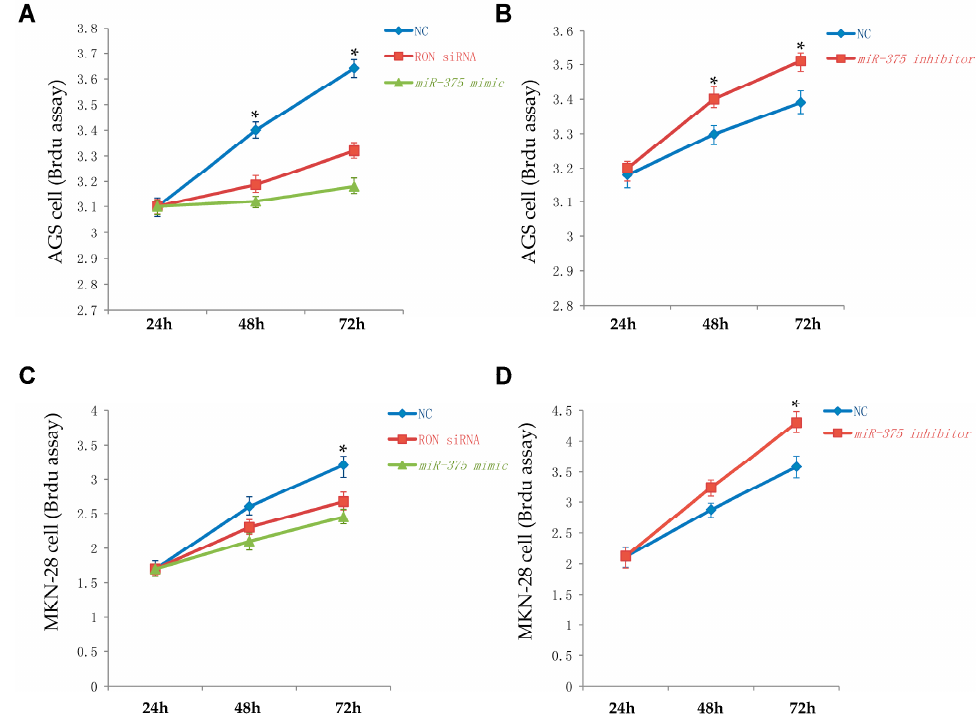
Figure 3. miR-375 and RON regulate cell proliferation in AGS and MKN-28 human gastric cancer cells. ( A ) Brdu assay in AGS cells transfected with a miR-375 mimic, a negative control, or RON siRNA; ( B ) Brdu assay in AGS cells transfected with a miR-375 inhibitor or a negative control; ( C ) Brdu assay in MKN-28 cells transfected with a miR-375 mimic, a negative control, or RON siRNA; ( D ) Brdu assay in MKN-28 cells transfected with a miR-375 inhibitor or negative control. * p < 0.05; The data represent the mean ± SD from triplicate measurements.